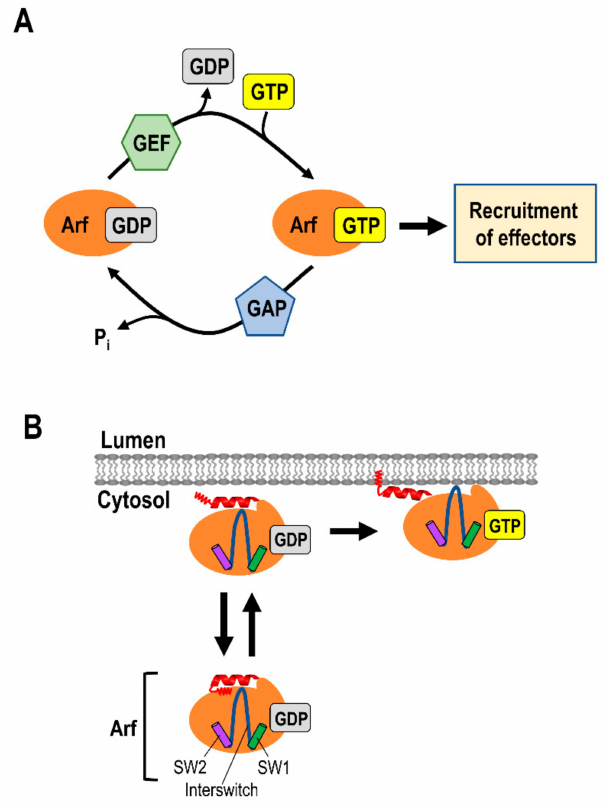
Figure 3. Regulation of Arf family small G proteins: ( A ) The state of the Arf small G proteins GTP binding and hydrolysis is regulated by Arf family guanine nucleotide exchange factors (GEFs) and GTPase-activating proteins (GAPs), respectively. The membrane-associated GTP-Arf then recruits e ff ectors such as cargo adaptor proteins, membrane lipid-modifying enzymes, and additional GEFs. ( B ) GDP-Arf associates with the surface of the membrane in a reversible manner. Exchange of GDP for GTP in Arf causes a conformational change of the switch (SW1 and SW2) and interswitch regions to enter the hydrophobic pocket occupied by the myristoylated N-terminal helix (red). GTP-Arf then associates tightly with the membrane via the exposed N-terminal